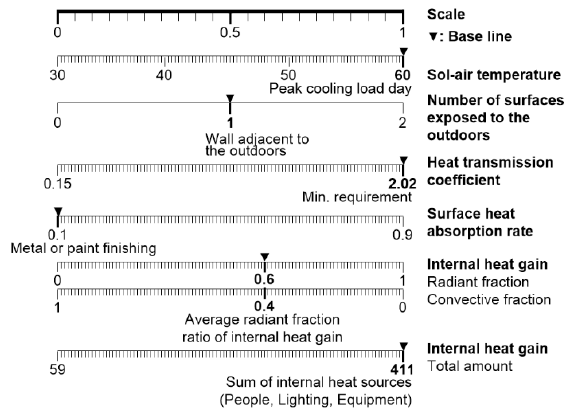
Figure 15. Scale of influencing factors.